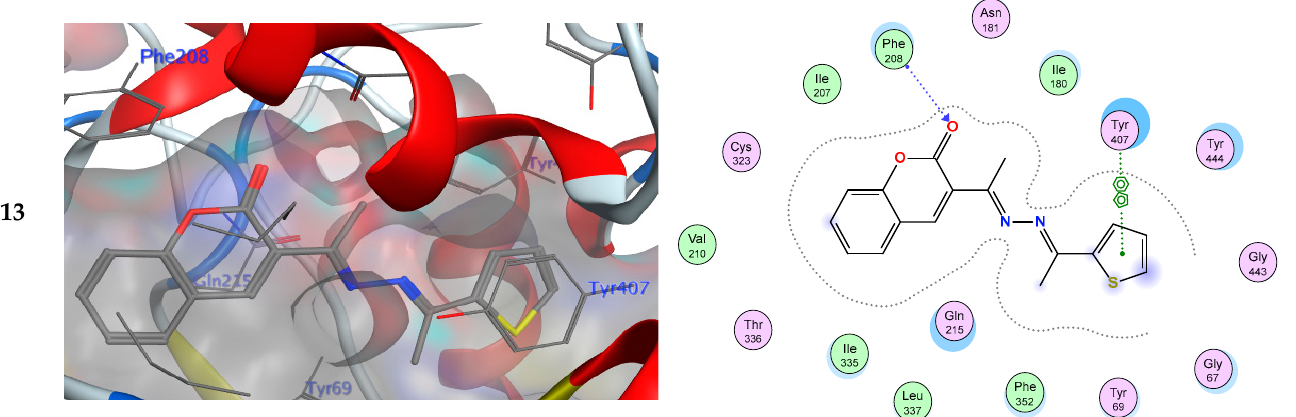
Figure 2. 3D- and 2D-ligand interactions within the binding site of 2Z5X for azine derivatives ( 3a – h , 5 , 7 , 9 , 11, and 13